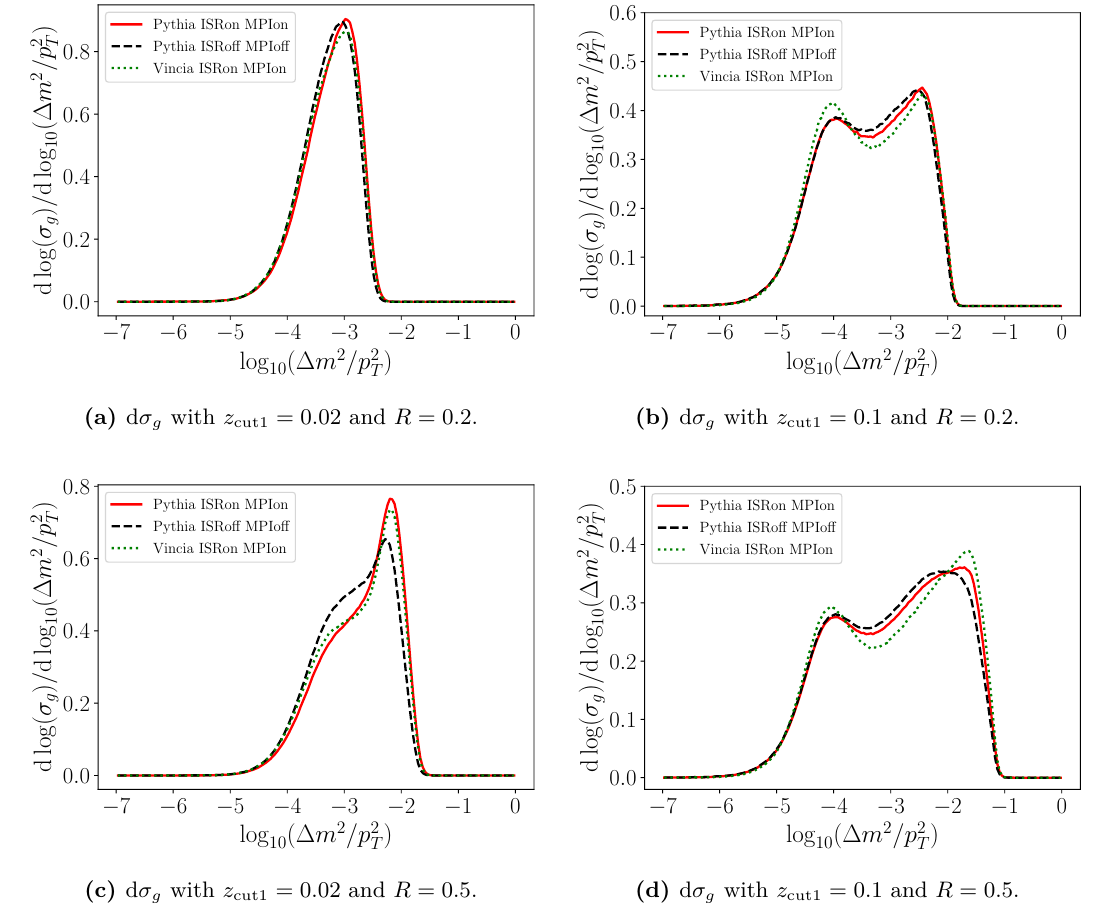
(c) d σ g with z cut1 = 0 . 02 and R = 0 . 5 . (d) d σ g with z cut1 = 0 . 1 and R = 0 . 5 . Figure 5. Monte Carlo results of the differential jet mass cross sections of gluon jets in collinear drop, with β 1 = β 2 = 0 . The top panels have R = 0 . 2 and the bottom panels have R = 0 . 5 , while the left panels have z cut1 = 0 . 02 and the right panels have z cut1 = 0 . 1 . The red solid and green dotted lines include ISR and MPI effects and are results from Pythia and Vincia , respectively. The black dashed line is the Pythia result without ISR and MPI